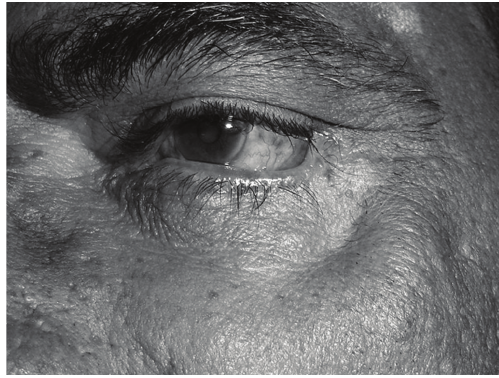
Figure 3: Postoperative picture demonstrating healed ulcer over left